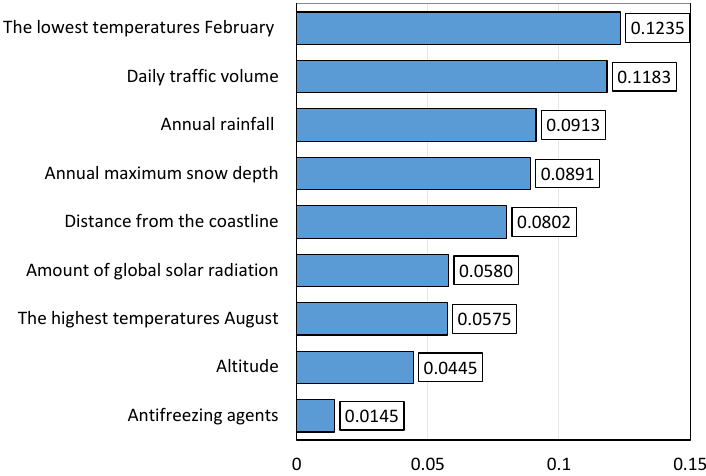
Figure 17. Range in concrete beams that have been in service for 40 – 50 years.